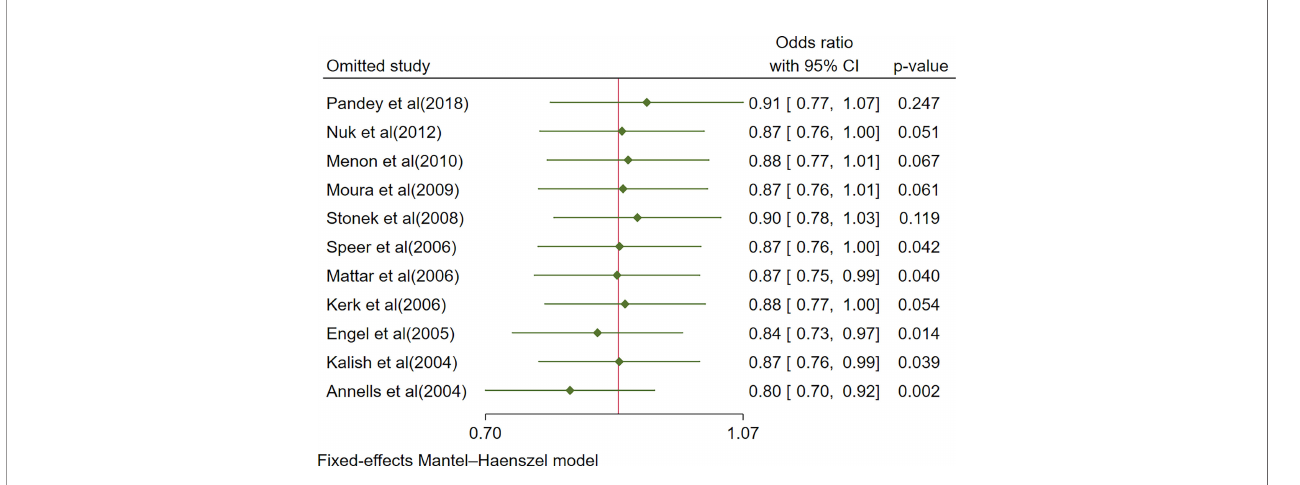
FIGURE 4 | Sensitivity analysis: Leave-one-out meta-analysis of IL-10-1082A/G(rs1800896) polymorphism and PTB (AA+GG vs.